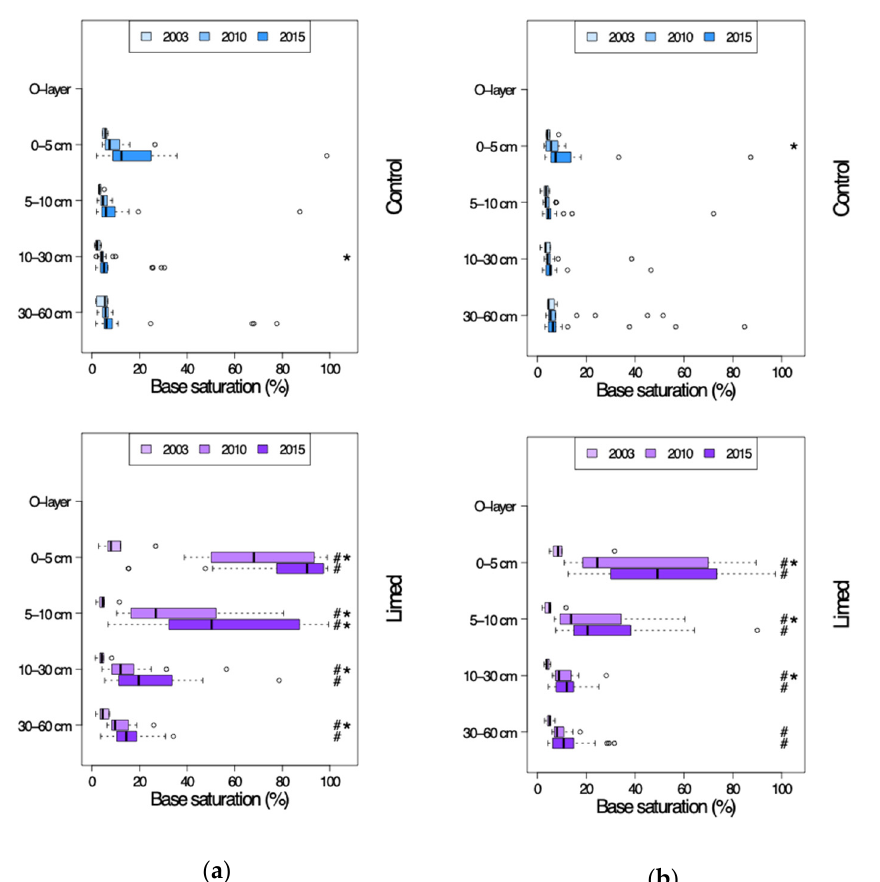
Figure 4. Base saturation in the soil profiles of control and lime treated plots in 2003–2015. ( a ) G1 study sites. ( b ) G2 study sites. #—limed plots significantly different from control; *—significant differences between current and previous sampling campaign.